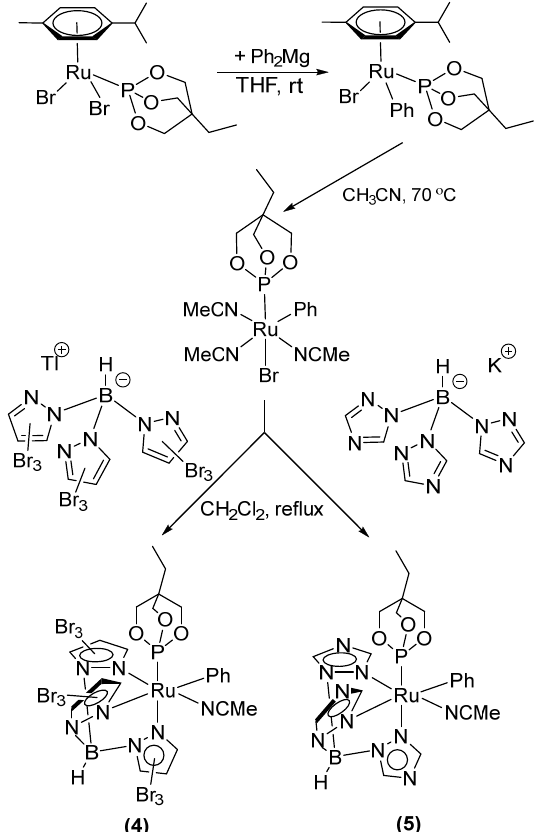
Scheme 4. Synthetic routes for the preparation of (Tp Br3 )Ru(P(OCH 2 ) 3 CEt)(NCMe)Ph ( 4 ) and (Ttz)Ru(P(OCH 2 ) 3 CEt)(NCMe)Ph ( 5